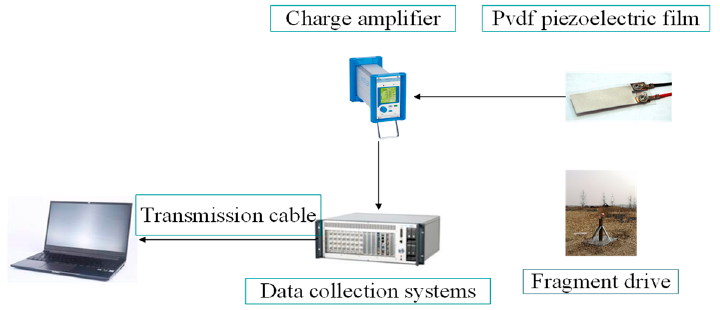
Figure 9. Schematic of interval impact target sound emission experiment system.